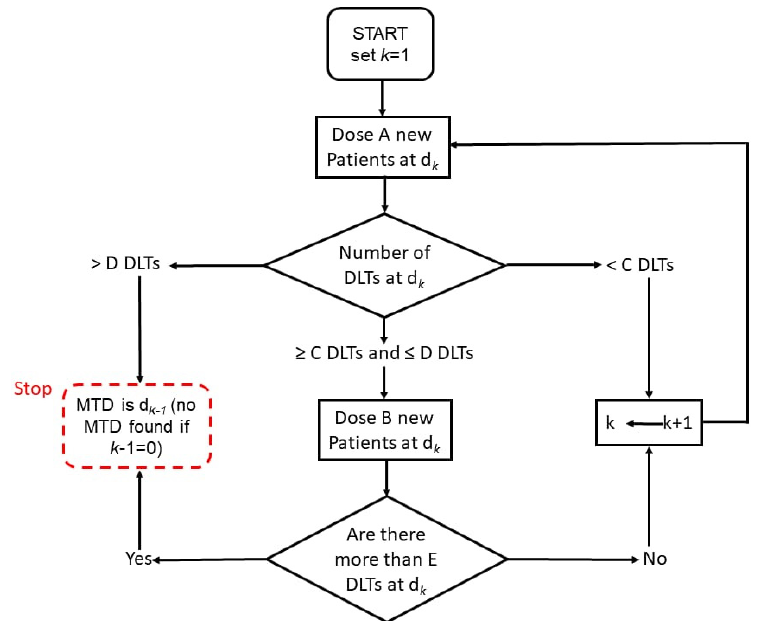
Figure 1. Schematic representation of A + B design without dose de-escalation.